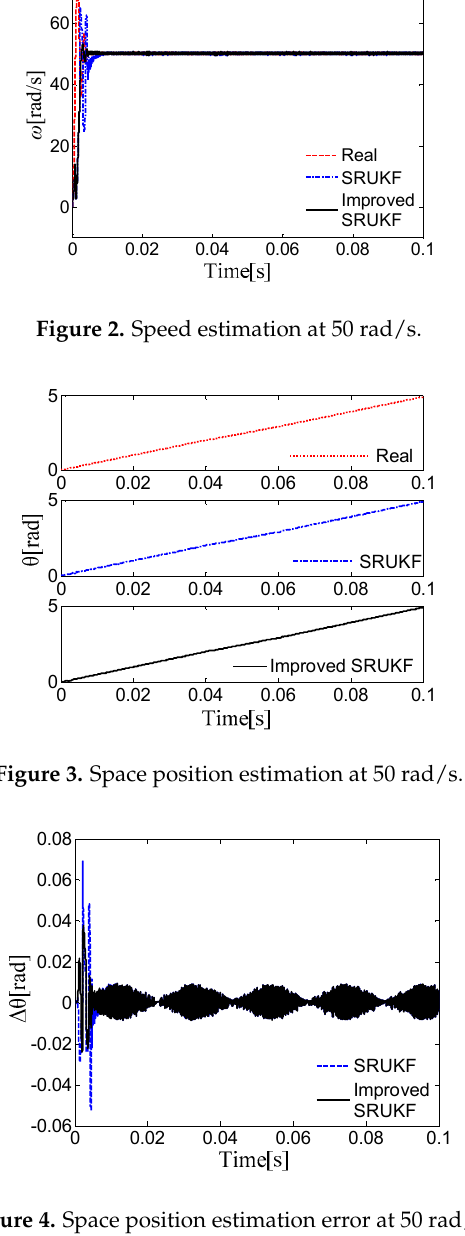
Figure 5. Speed estimation at 800 rad/s.